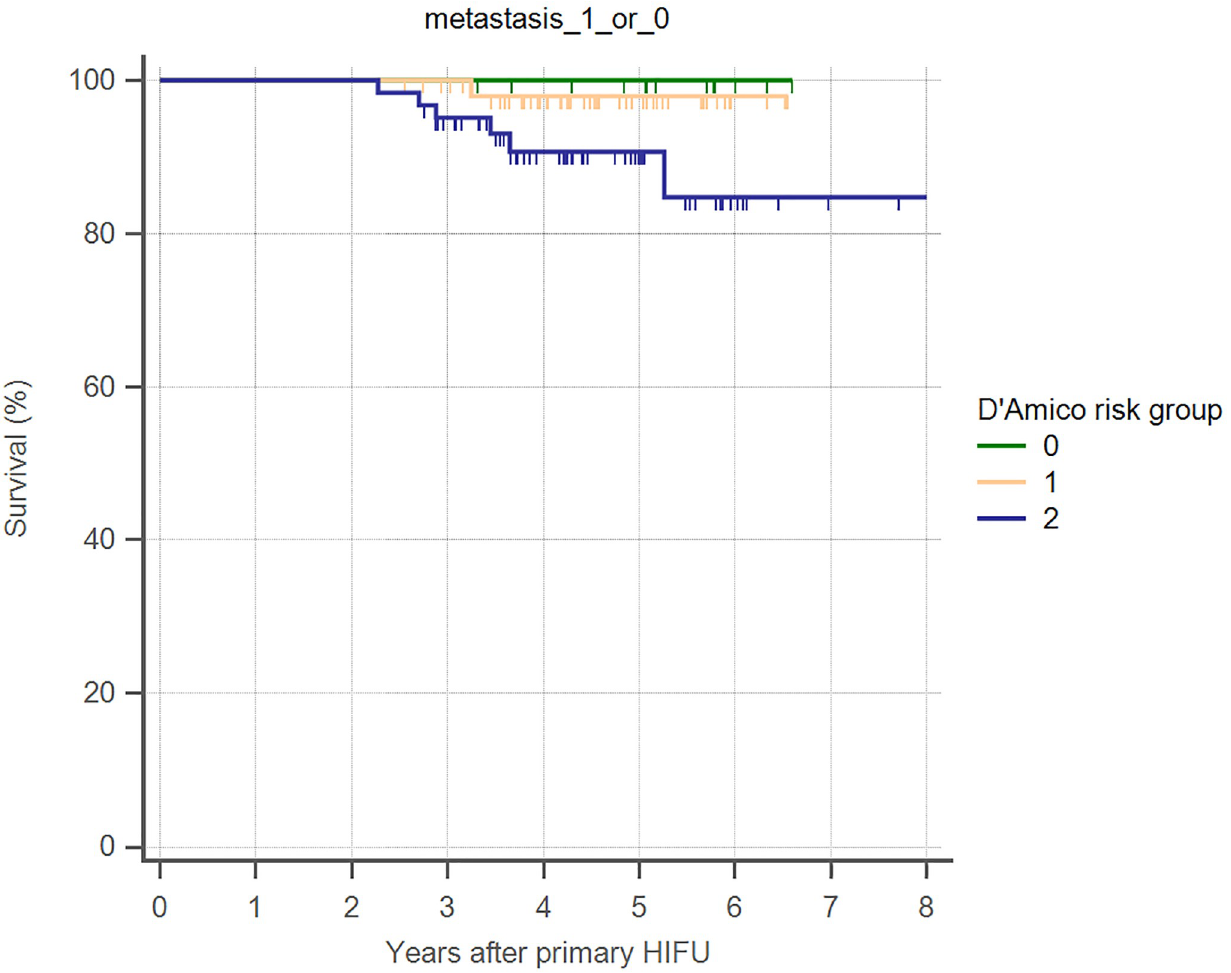
Fig 4. Kaplan–Meier curves illustrating metastasis-free survival, by D’Amico risk groups, in men undergoing WG-HIFU for prostate cancer.